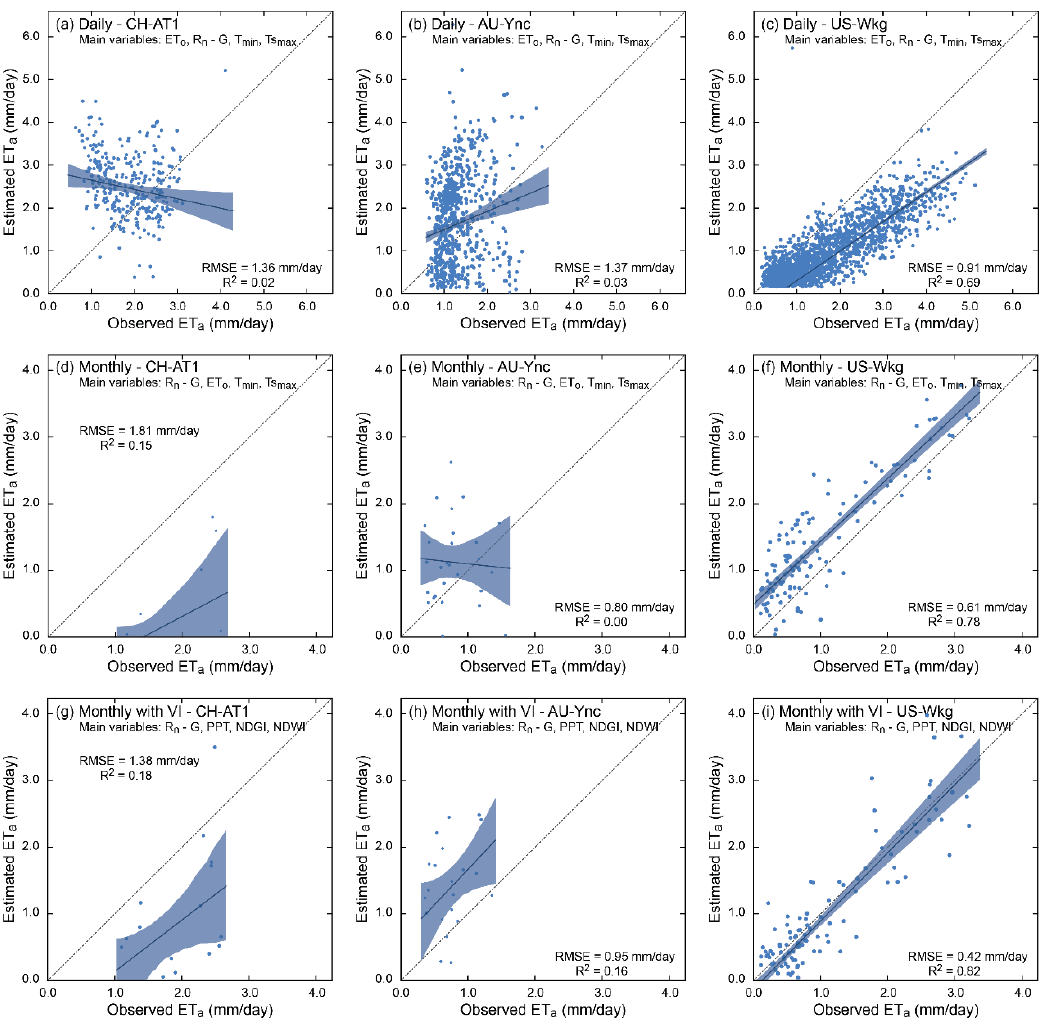
Figure 9. Performance of the global formulae in the validation sites. CH-AT1, AU-Ync, and US-Wkg are shown from left to right. Daily, monthly, and VI monthly formulae are shown from the top to the bottom. Each panel includes the main variable selected for the construction of each formula, the RMSE, and R². The blue band corresponds to the 95% confidence interval.